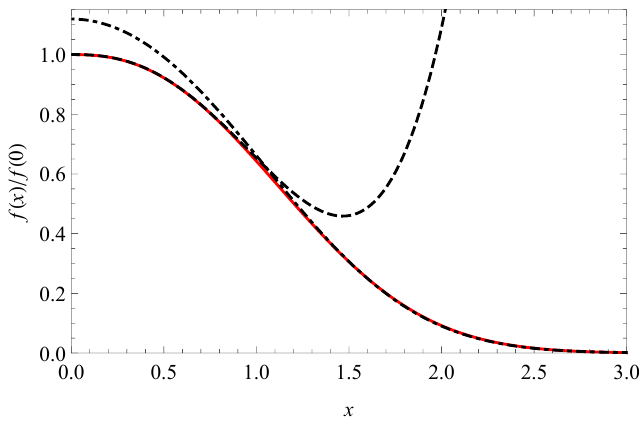
Figure 6: Red solid line: numerical solution to Eq. (49). Black dashed: low energy approximation, Eq. (53). Black dot-dashed: high energy approximation, Eq.